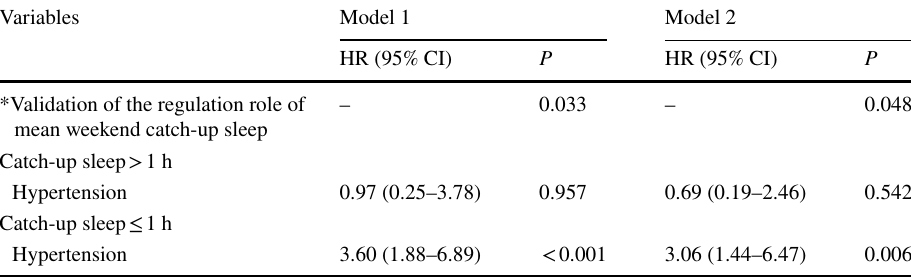
Table 3 Roles of mean weekend catch-up sleep on the association between hypertension and all-cause